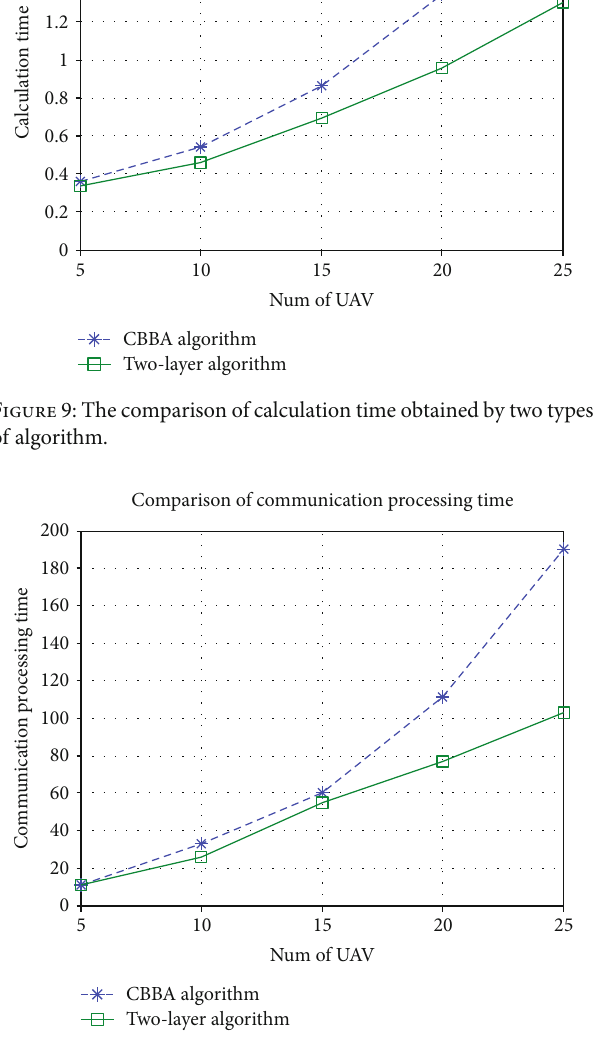
Figure 10: The comparison of communication processing times obtained by two types of algorithm.